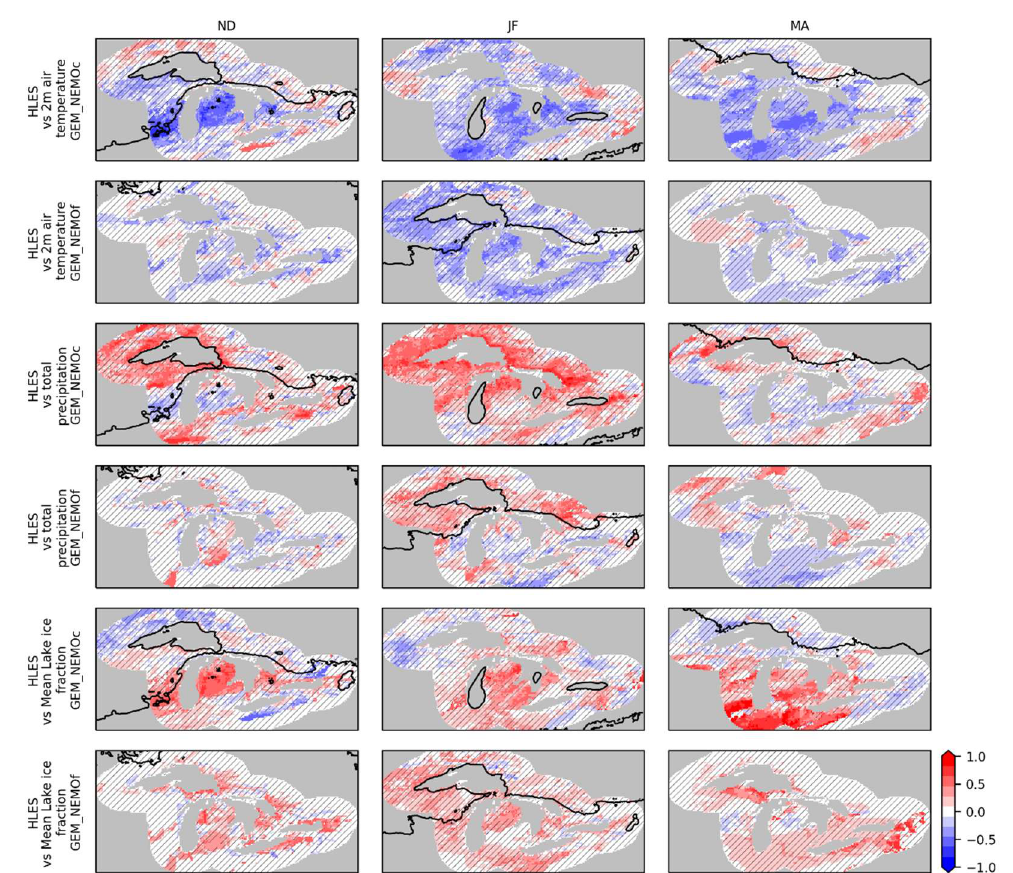
Figure 6. Correlation maps of HLES amount with respect to 2m air temperature, total precipitation and lake ice fraction for the onset (ND), active (JF) and decline (MA) phases, for the 1989–2010 period (GEM_NEMOc) and the 2079–2100 period (GEM_NEMOf). Grid cells with no significant correlations at 10% significance level are hatched.